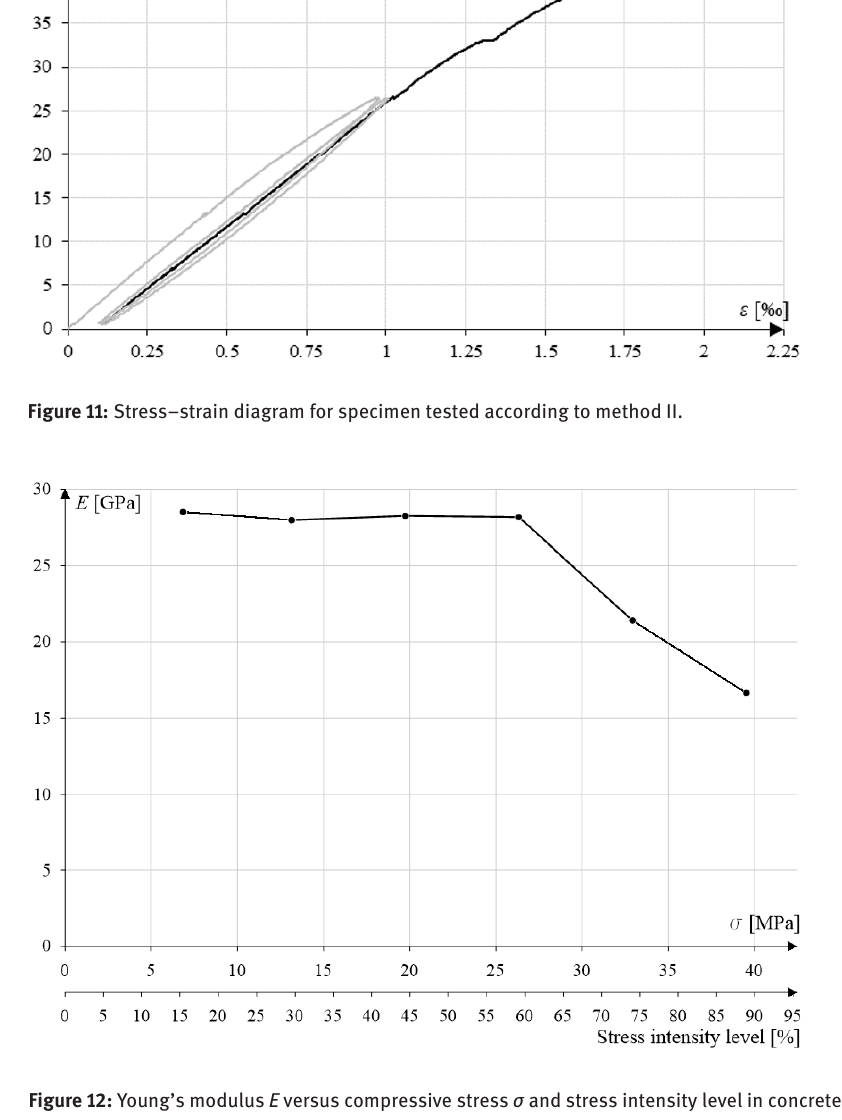
Figure 12: Young’s modulus E versus compressive stress σ and stress intensity level in concrete (method